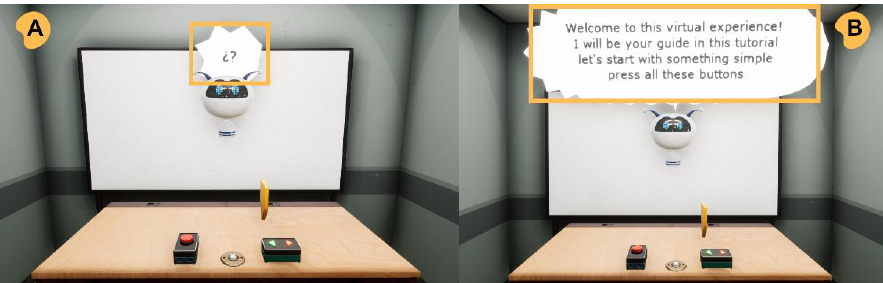
Figure 3. Example of a screen of the iVR tutorial: ( A ) Robot assistant in standby mode; ( B ) Robot assistant displaying information.